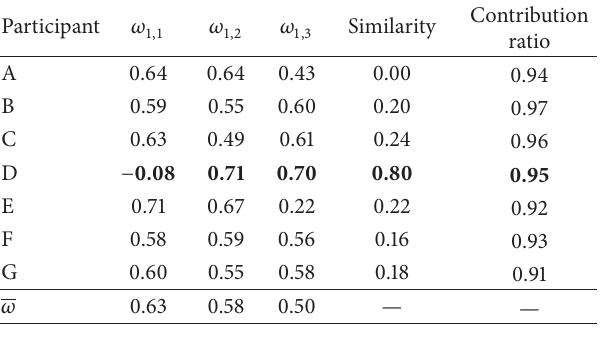
Table 3: Elements of weighting vectors of first principal component.